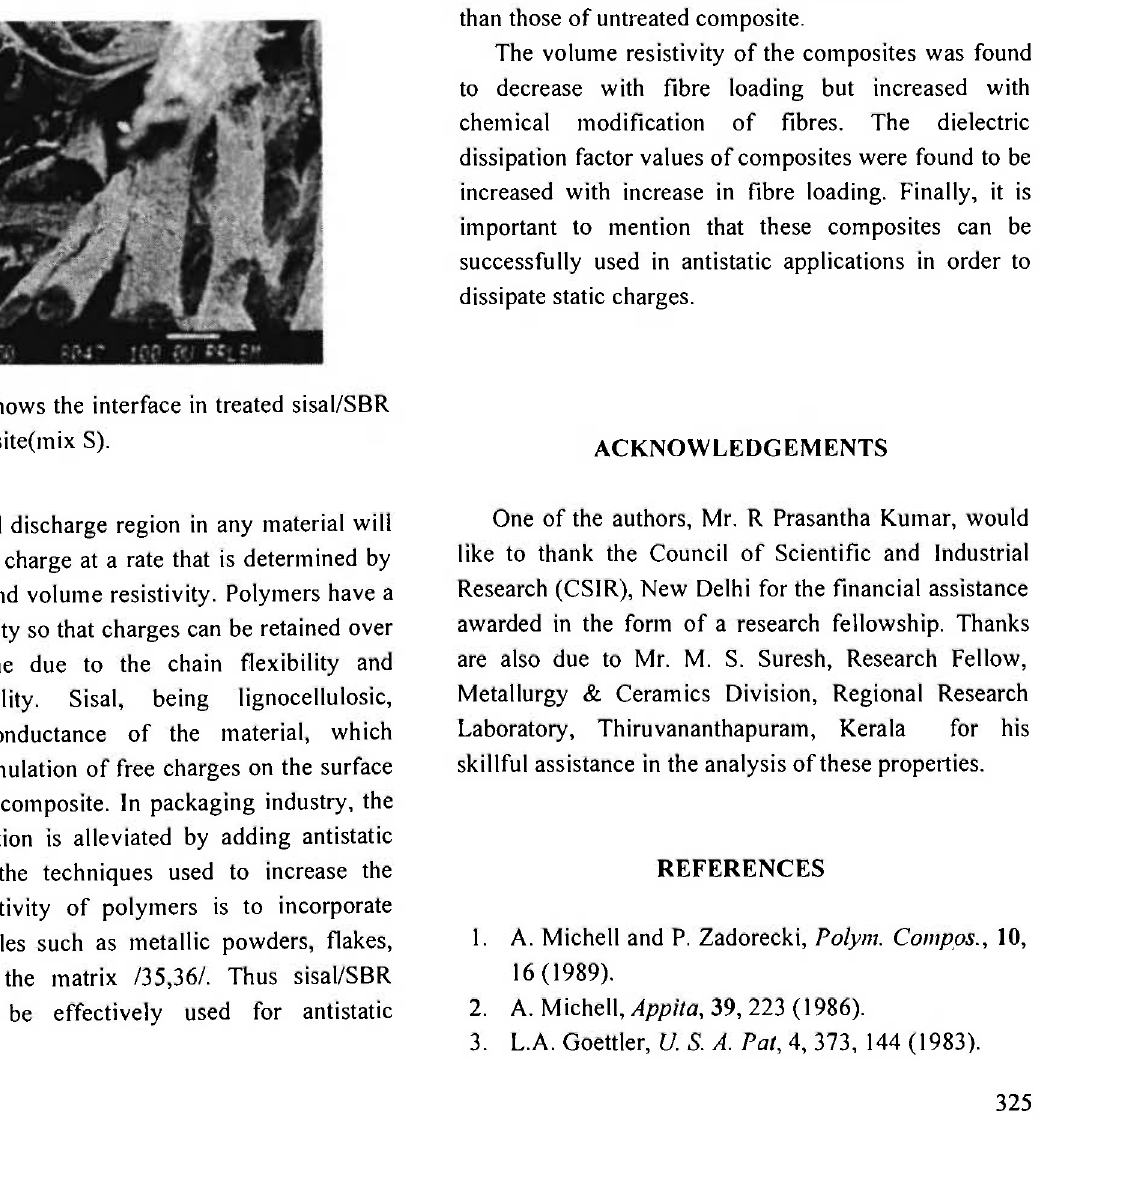
Fig. 12: SEM showing rubber fragments adhered on the fibre surface(mix L).